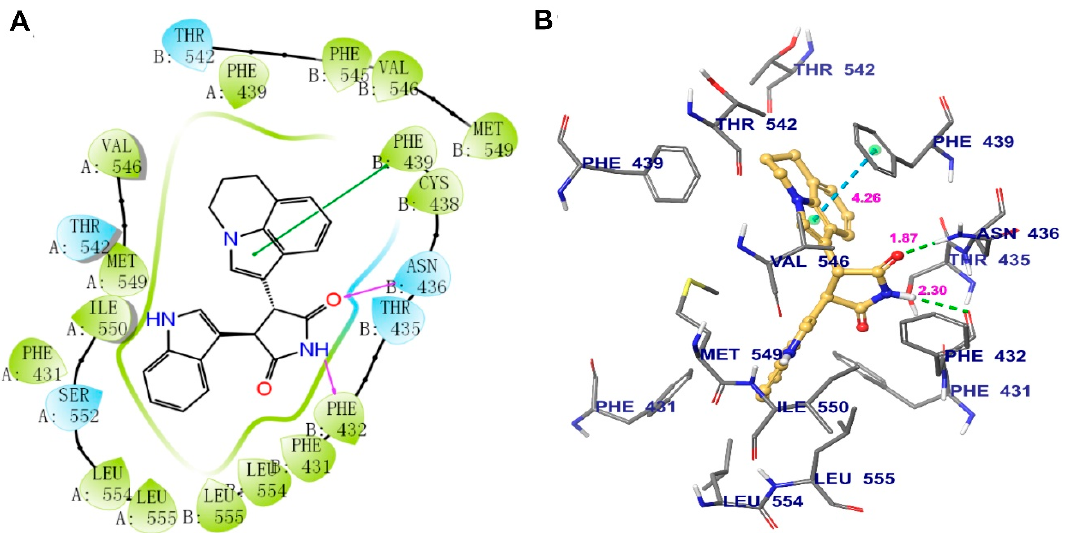
Figure 6. The binding mode of tivantinib to the human ABCG2 model, as predicted by induced-fit docking. ( A ) A 2D schematic diagram of the ligand–receptor interaction between tivantinib and the human ABCG2 model. Amino acids within 4 Å are indicated as colored bubbles, polar residues are depicted in blue, and hydrophobic residues are depicted in green. Purple arrows denote H-bonds and green lines denote π – π stacking aromatic interactions. ( B ) The docked conformation of tivantinib (ball and rod model) is shown within the ABCG2 drug-binding cavity, with the atoms colored as follows: carbon, yellow; hydrogen, white; oxygen, red; nitrogen, blue. Important amino acid residues are described (rods model) with the same color scheme as above for all atoms but with carbon atoms in gray. Dotted green lines represent hydrogen-bonding interactions, while dotted azure lines represent π – π stacking interactions. The values of the correlation distances are indicated in Å.